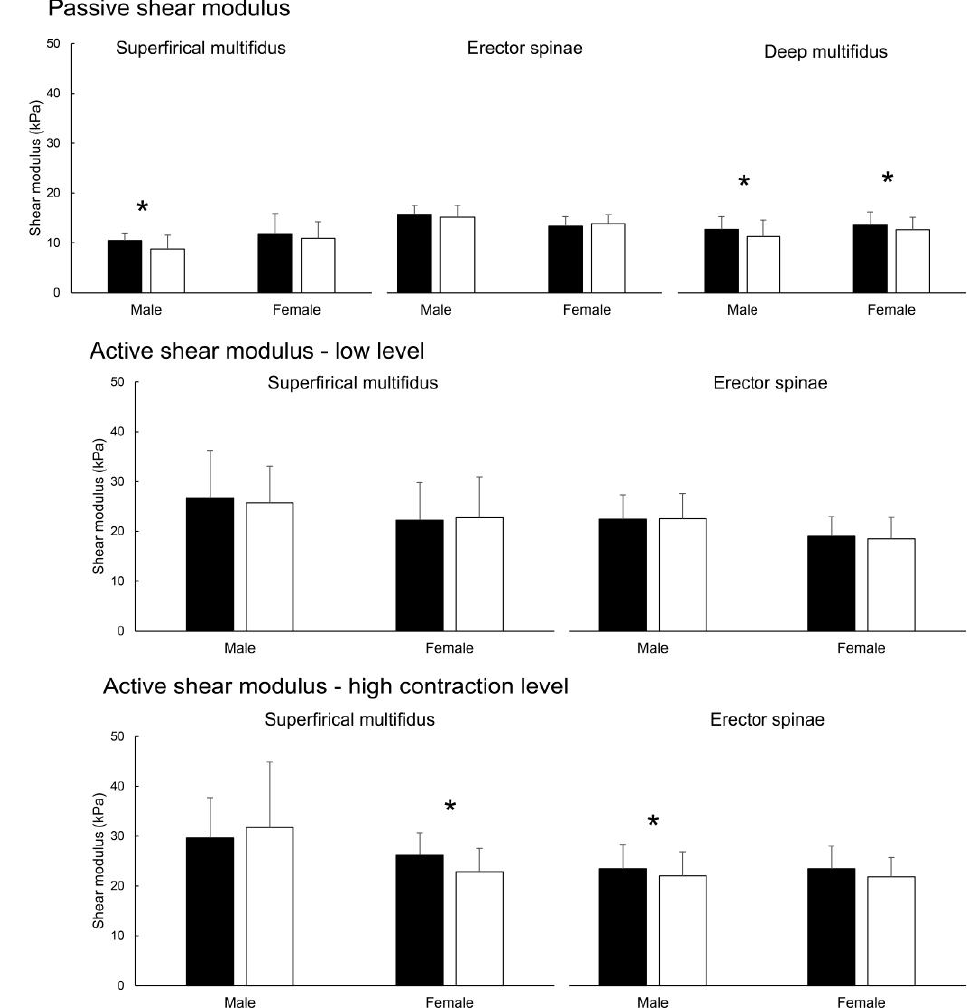
Figure 5. Sex-specific data across muscles and conditions. * Denotes statistically significant pair-wise effect (pre-fatigue vs. post-fatigue).